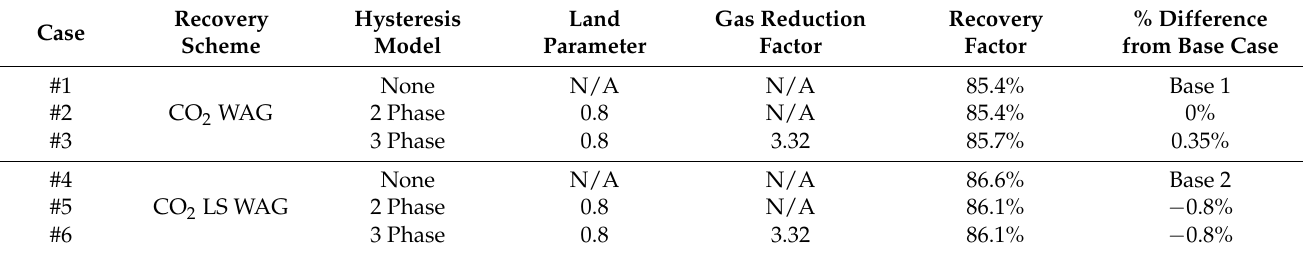
Table 12. Summary of simulation